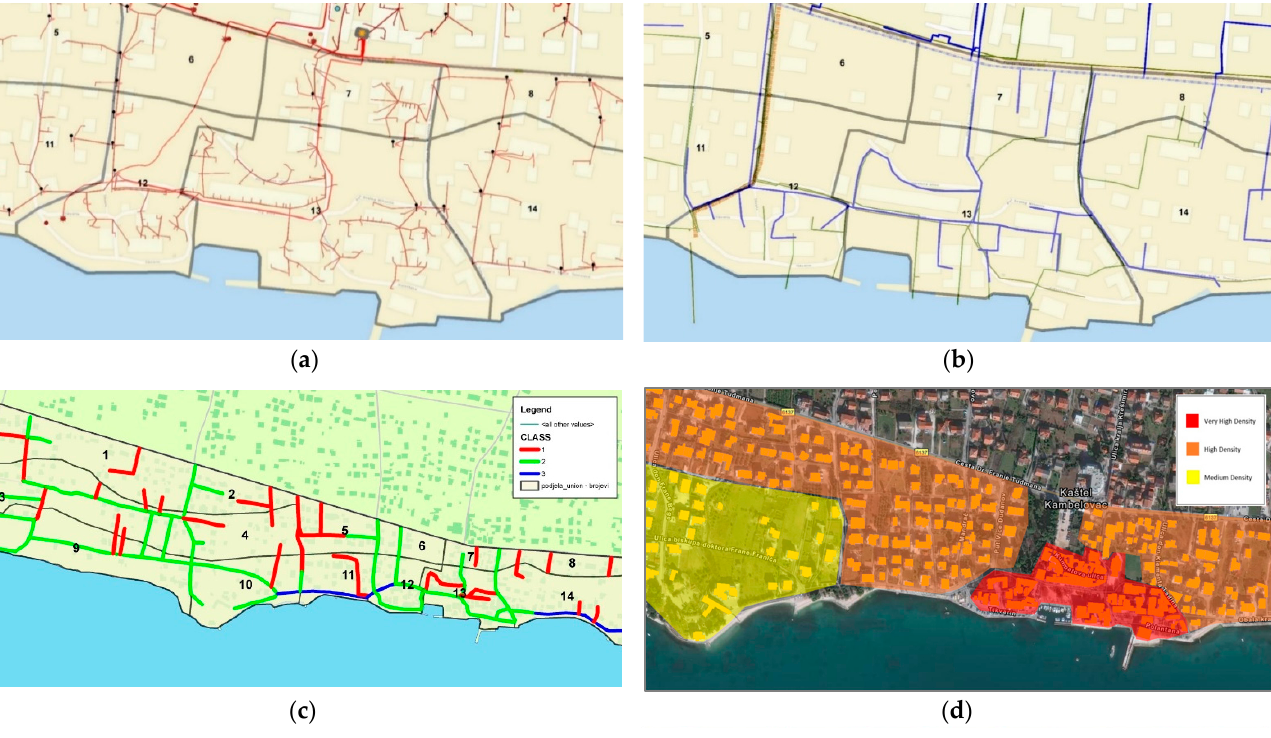
( f ) Figure 10. GIS analysis of additional criteria: ( a ) electricity supply; ( b ) water supply and drainage; ( c ) road network; ( d ) construction density; ( e ) importance factor (public, school, etc.); ( f ) historical buildings. All the above-mentioned data have been collected into the decision matrix to be used by the PROMETHEE method with the help of Visual PROMETHEE software (Figure 11). Figure 11. Homogenous zones input data for PROMETHEE method (decision matrix).